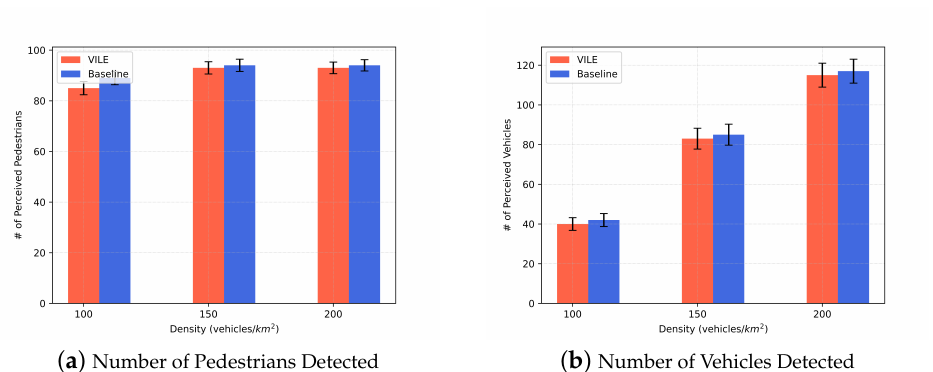
Figure 7. Absolute number of objects detected with collective